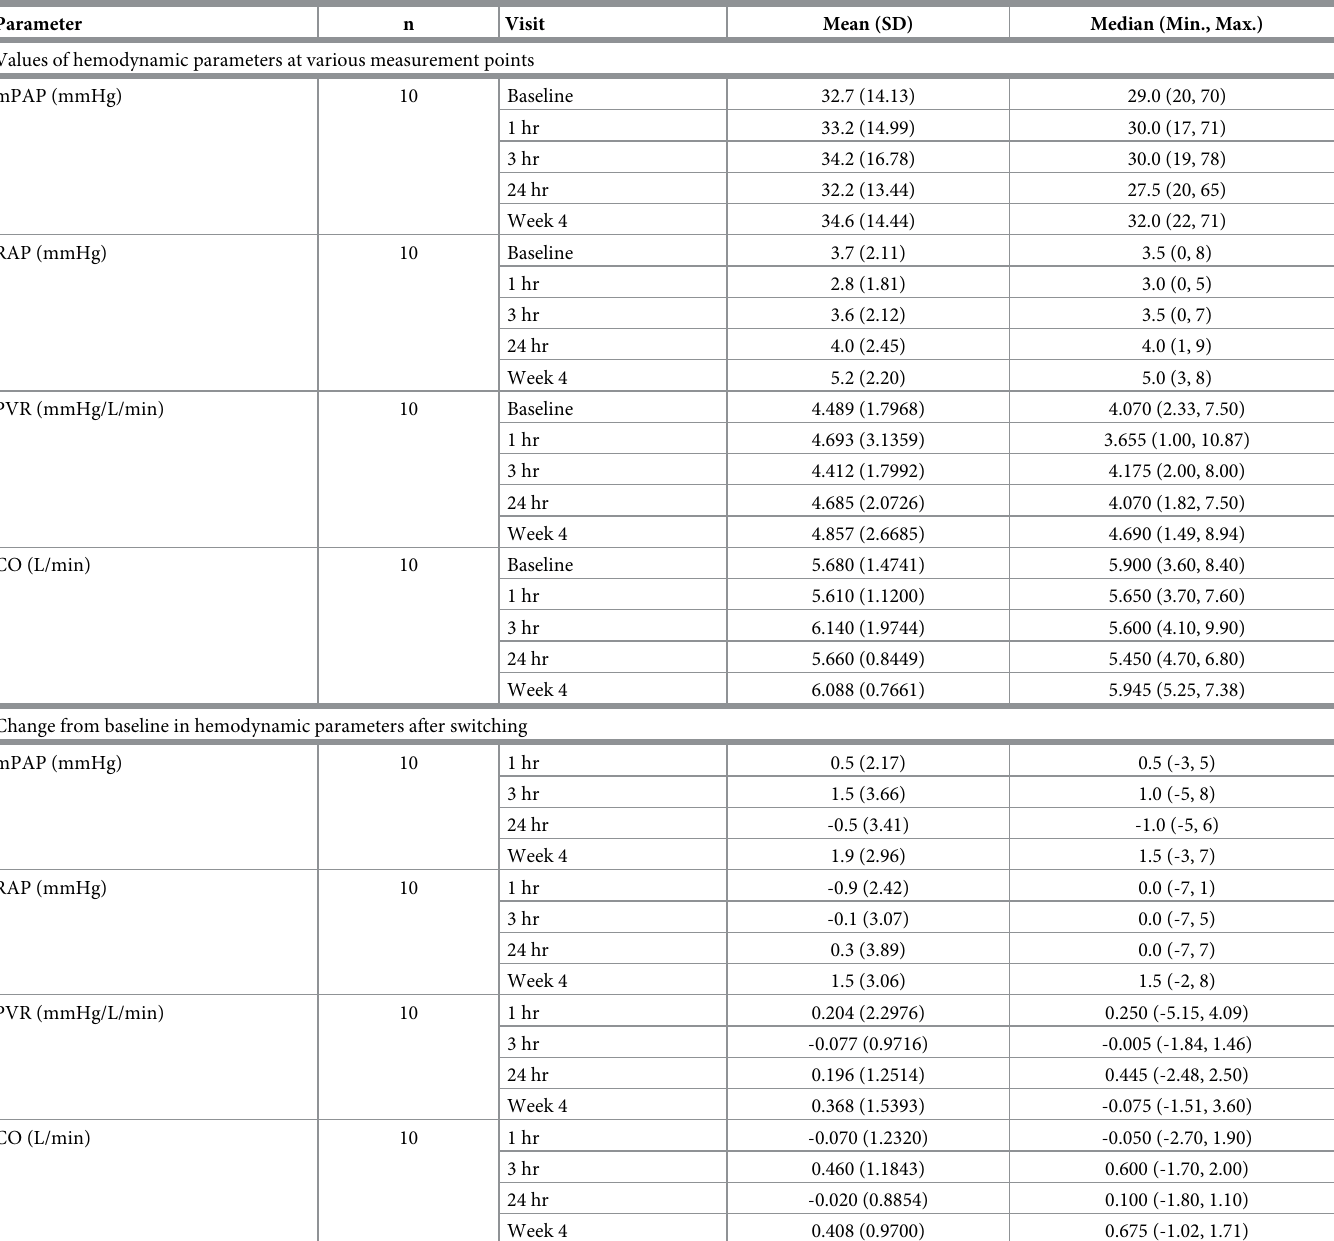
Table 4. Changes from baseline in mPAP, RAP, PVR, and CO after switching. Parameter n Visit Mean (SD) Median (Min., Max.) Values of hemodynamic parameters at various measurement points mPAP (mmHg) 10